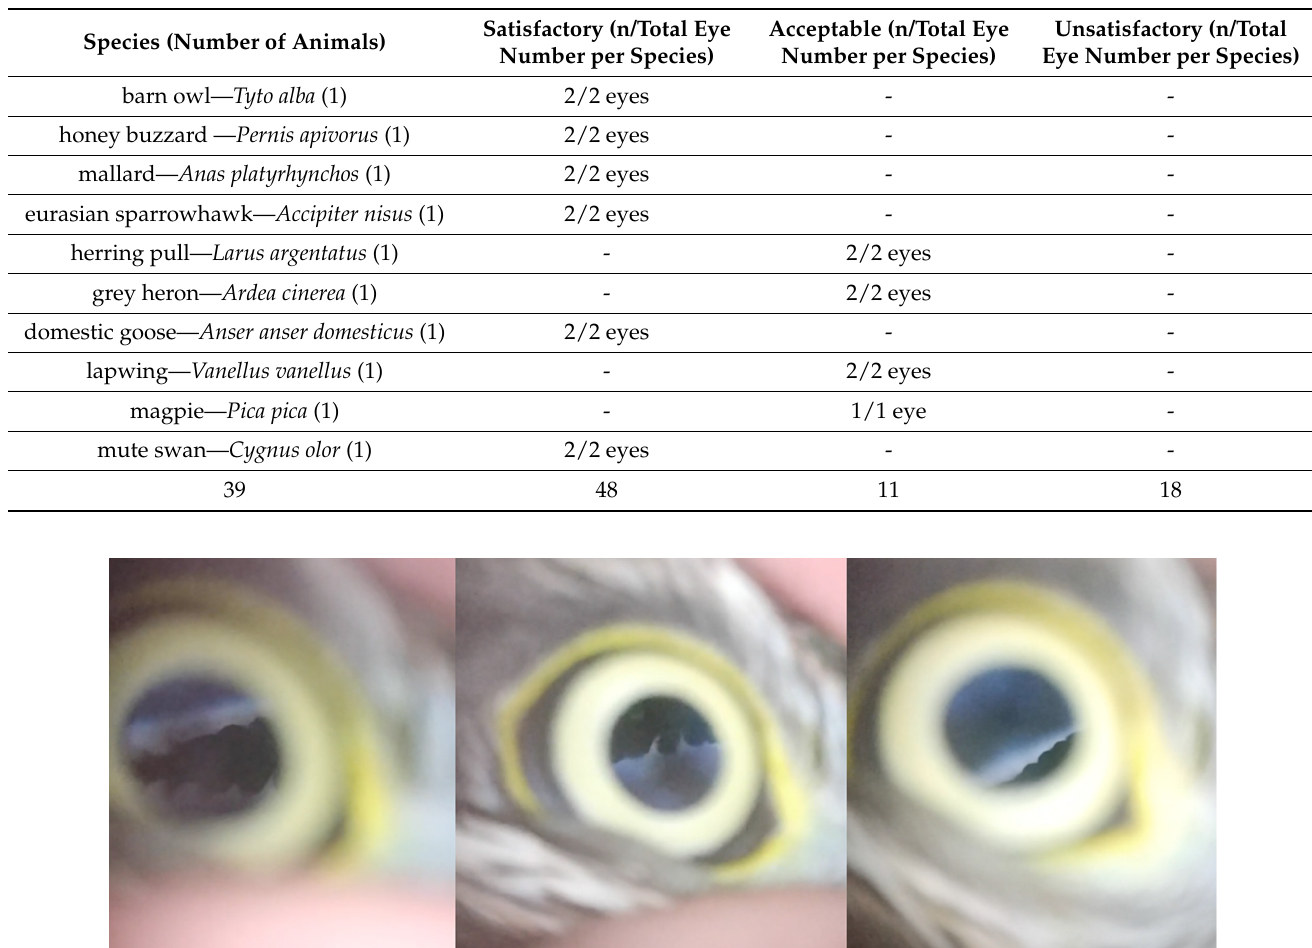
Figure 3. Fundus of an Eurasian sparrowhawk ( Accipiter nisus ) showing pecten normal aspect. This fundus examination was classified as satisfactory.